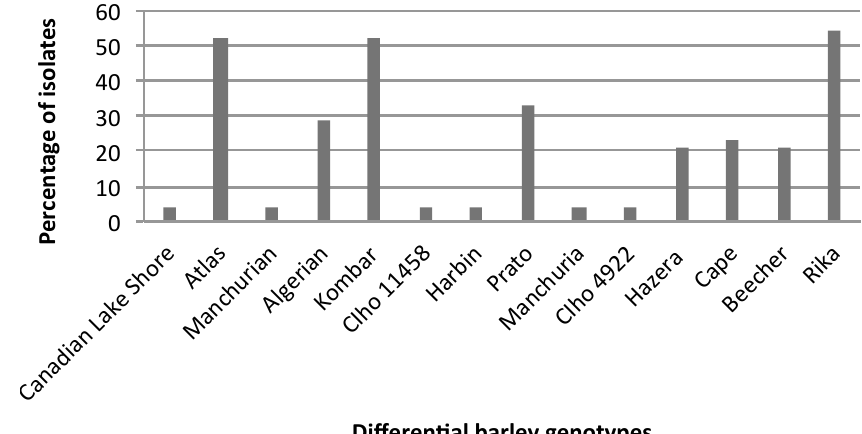
Figure 1. Proportions of tested isolates of Pyrenophora teres f. teres with virulence to barley